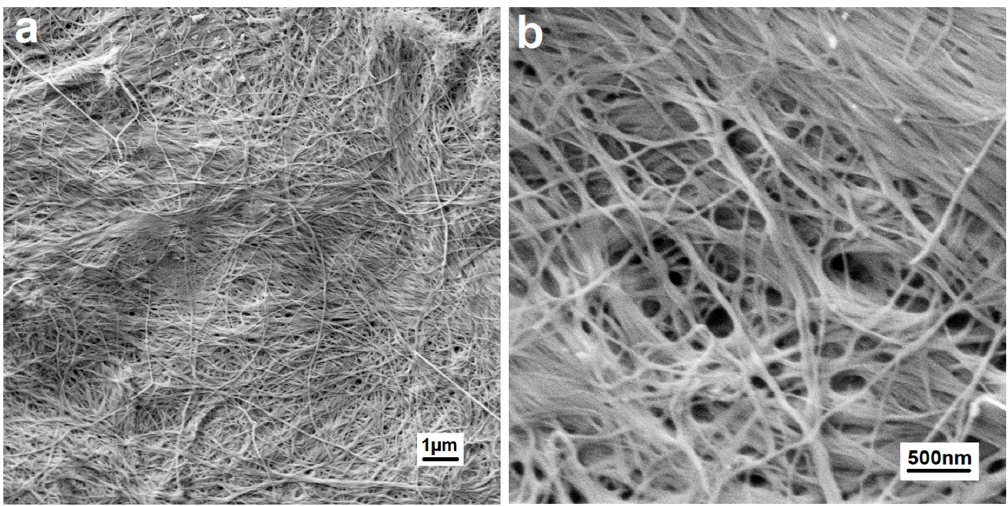
Figure 7. FEG-SEM images of TOBC/CD hybrid nanopaper at different magnification. Figure 7 . FEG-SEM images of TOBC/CD hybrid nanopaper at different magnification.